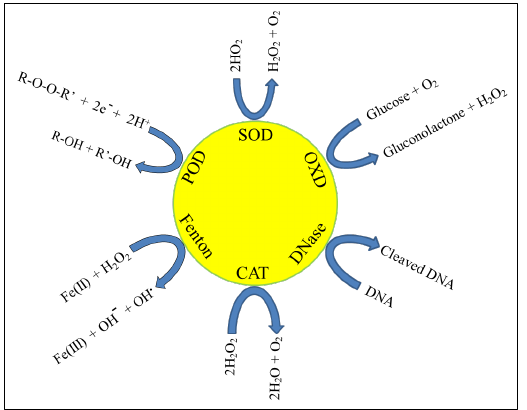
Figure 1. Key enzymes and their reactions for antibacterial and anticancer use.